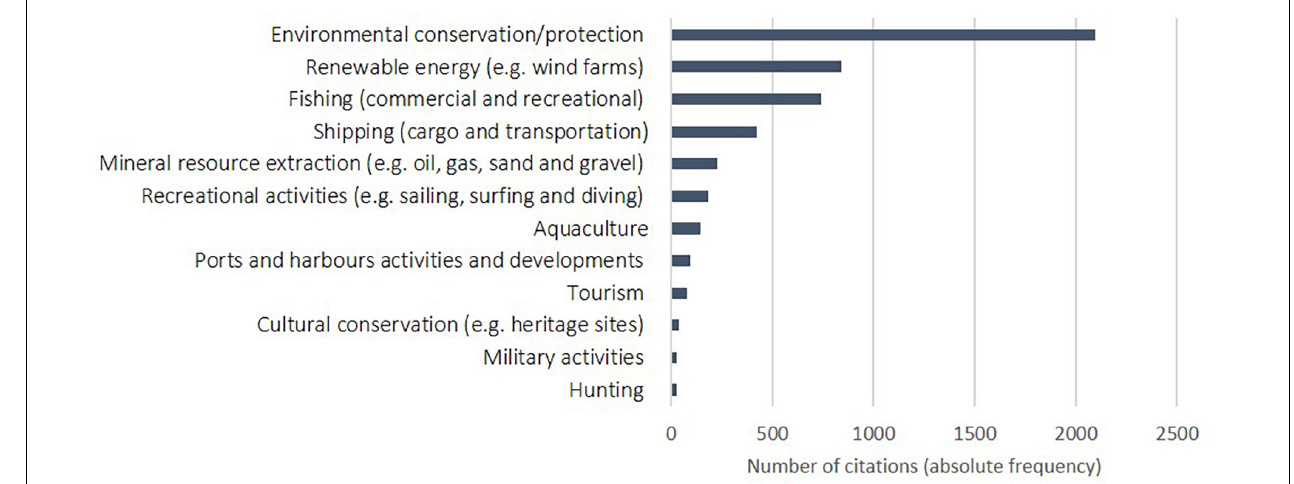
FIGURE 5 | A word count on key activities that can be addressed through